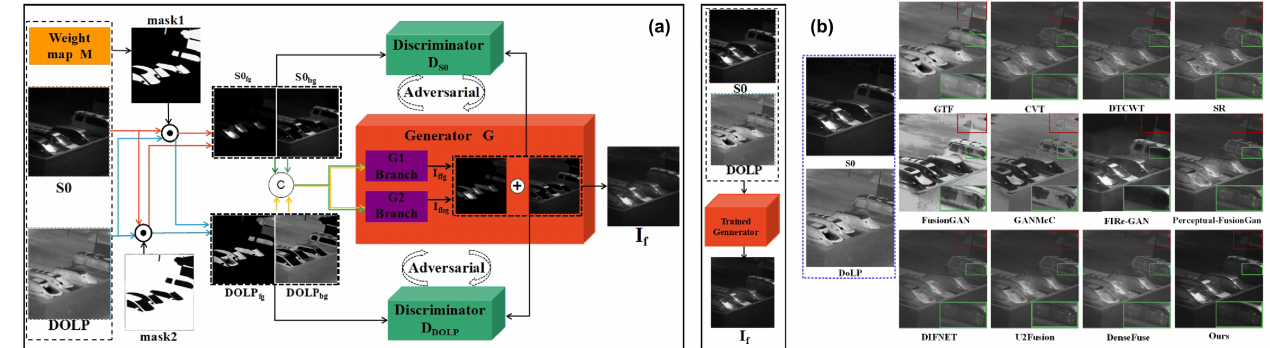
Figure 19. ( a ) Overall network structure of the proposed SGPF-GAN, ( b ) A polarized image fusion result